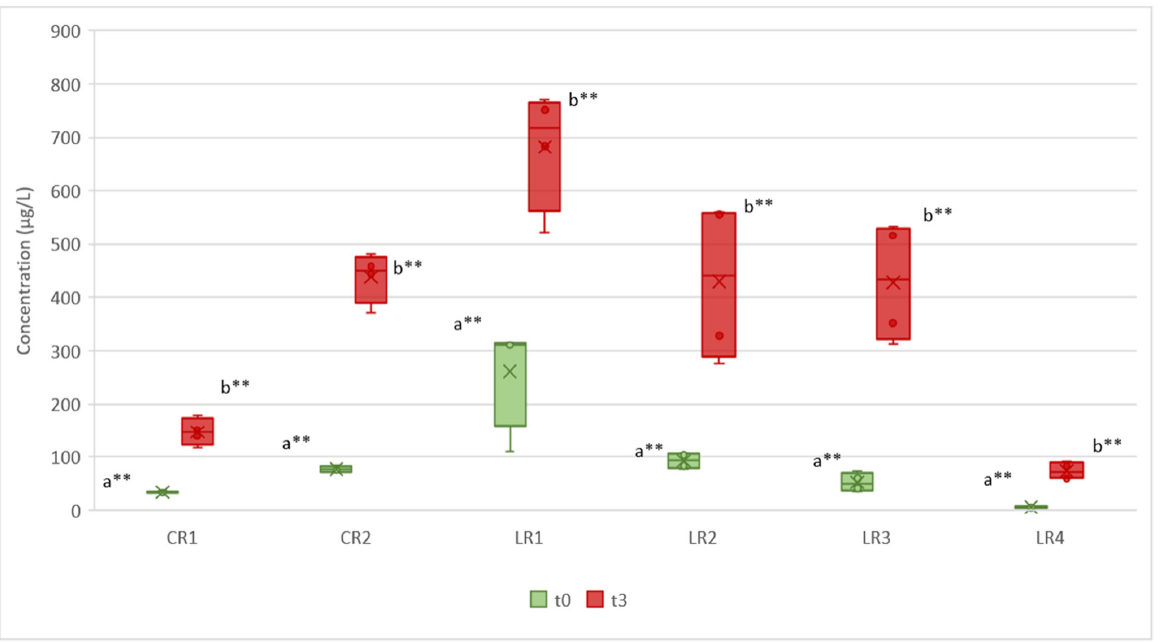
Figure 1. Evolution of the DMS concentration ( μ g/L) between bottling (t0) and after three months of accelerated bottle ageing (t3) for six different wine samples (CR1, CR2, LR1, LR2, LR3 and LR4) (a and b: a different letter means there is a significant difference between the two groups; **: significant difference at 5%).